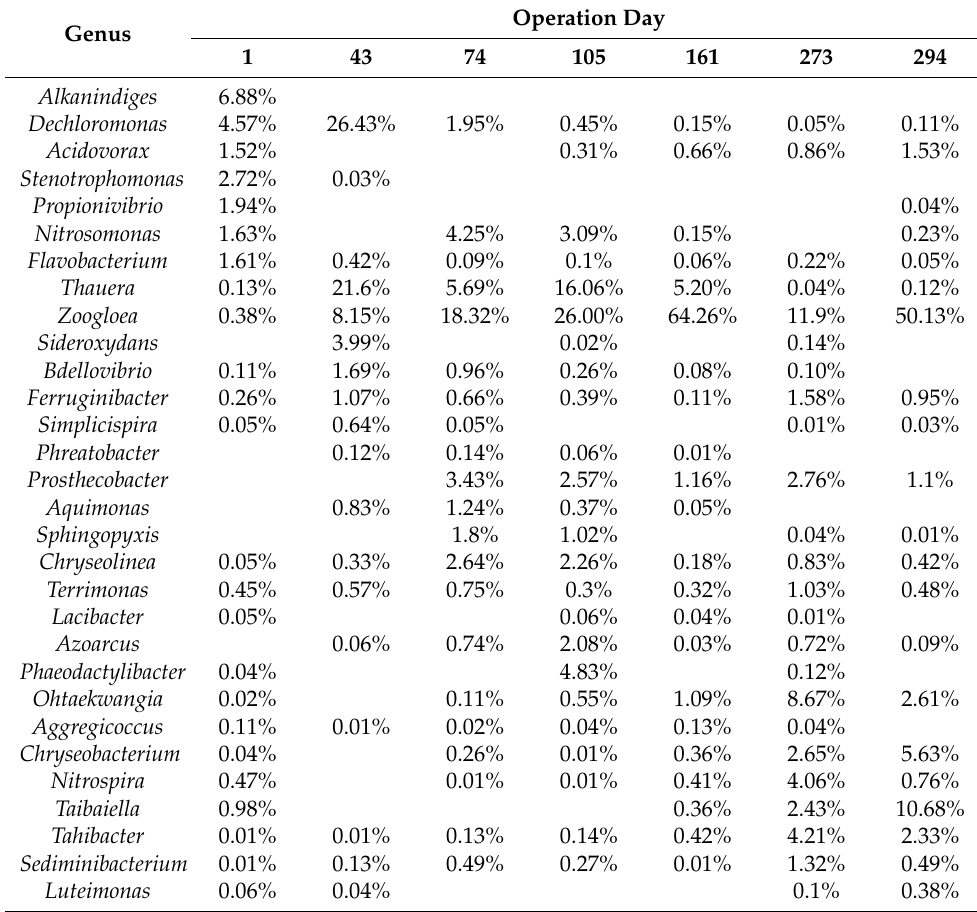
Table 1. Predominant microbial genera in